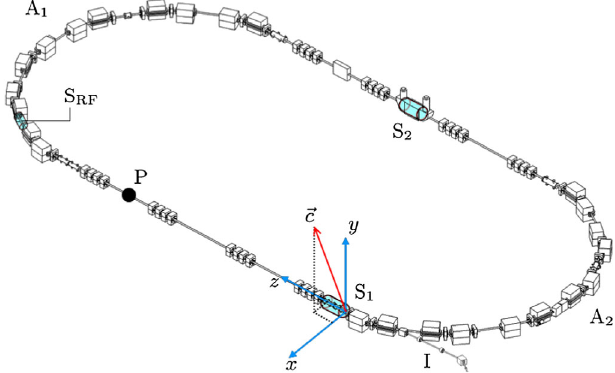
FIG. 1. Sketch of the experimental setup with two solenoids S 1 and S 2 located in the opposite straight sections of the COSY ring. The vector ⃗ c indicates the spin closed orbit before solenoid S 1 , when S 1 and S 2 are switched off. The two arcs are denoted by A 1 and A 2 , P shows the location of the polarimeter, S of the rf solenoid, and I indicates the injection. The beam orbits in clockwise direction in the